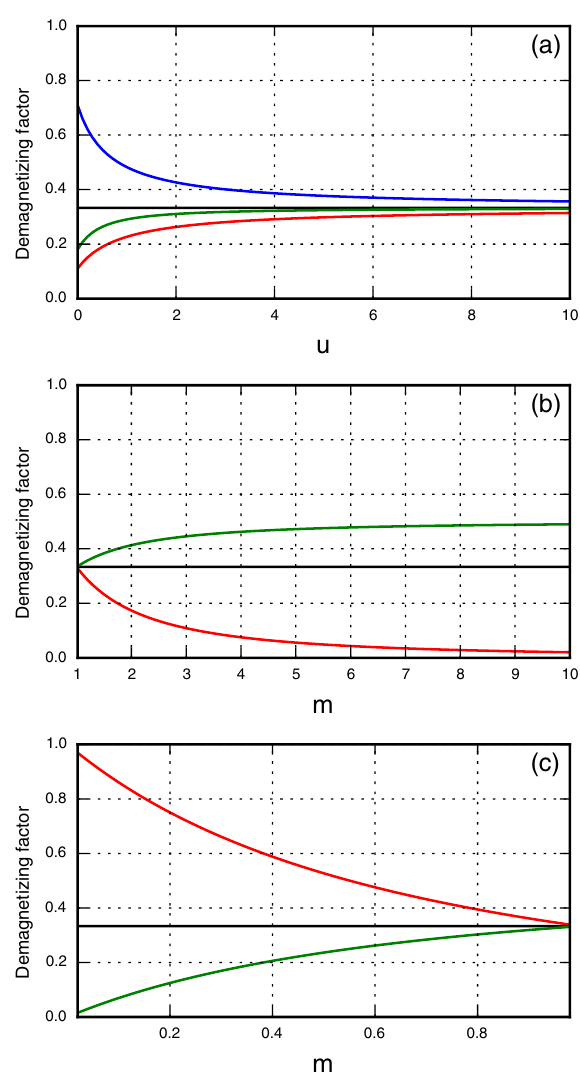
Figure 2. (a) Comparison between the demagnetizing factors e n † 11 (in red), e n † (in green) and e n † (in blue) produced by 100 triaxial 22 33 ellipsoids with semi-axes a = a 0 + u b 0 , b = b 0 + u b 0 and c = c 0 + u b 0 , where 0 ≤ u ≤ 10 and b 0 = 700m. The demagnetizing factors were calculated by using Eqs. (25), (26) and (27). (b) Comparison between the demagnetizing factors e n † (in red) and e n † (in green) 11 22 produced by 100 prolate ellipsoids with semi-axes a = m b 0 and b = b 0 , where 1 . 02 ≤ m ≤ 10 and b 0 = 1000m. The demagnetizing factors were calculated by using Eqs. (30) and (31). (c) Comparison between the demagnetizing factors e n † (in red) and e n † (in green) 11 22 produced by 100 oblate ellipsoids with semi-axes a = m b 0 and b = b 0 , where 0 . 02 ≤ m ≤ 0 . 98 and b 0 = 1000m. The demagnetizing factors were calculated by using Eqs. (32) and (33). The horizontal black line represents the value 1 /